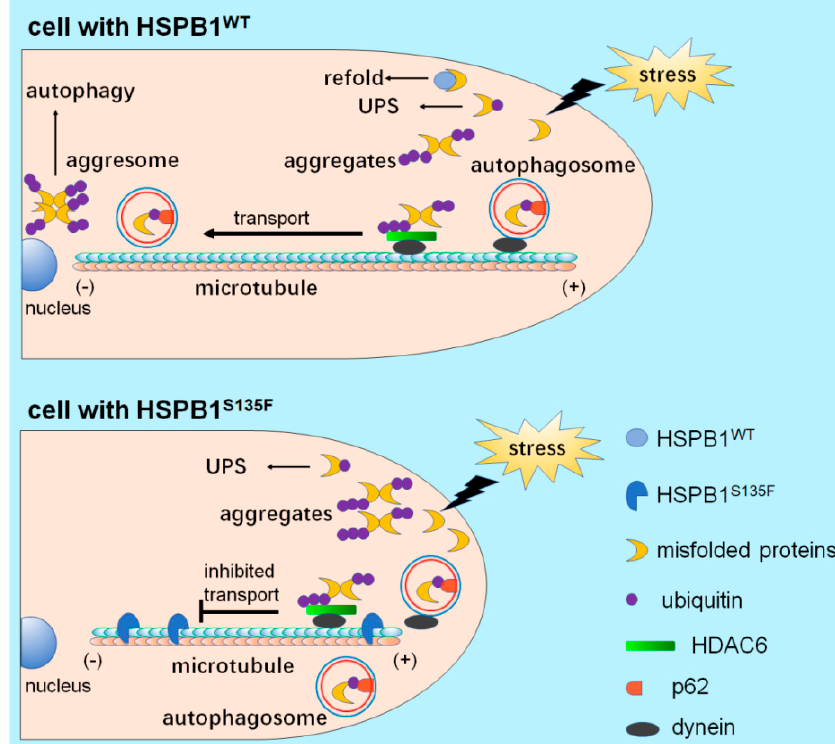
Figure 8. An integrative stress-based model of HSPB1 S135F -induced accumulation of misfolded proteins. Supplementary Materials: The following are available online at https://www.mdpi.com/article/10 .3390/cells11182886/s1, Figure S1. Stress-induced aggresomes in HEK293T cells were shown as dark inclusions by phase contrast microscope. Figure S2. HSPB1 S135F prevents perinuclear transport of p62 in SH-SY5Y cells under stress